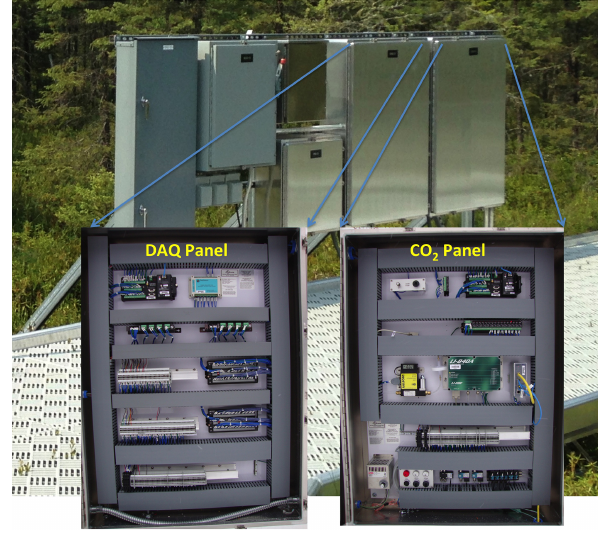
Figure 3. Data acquisition panel (left) and CO 2 panel